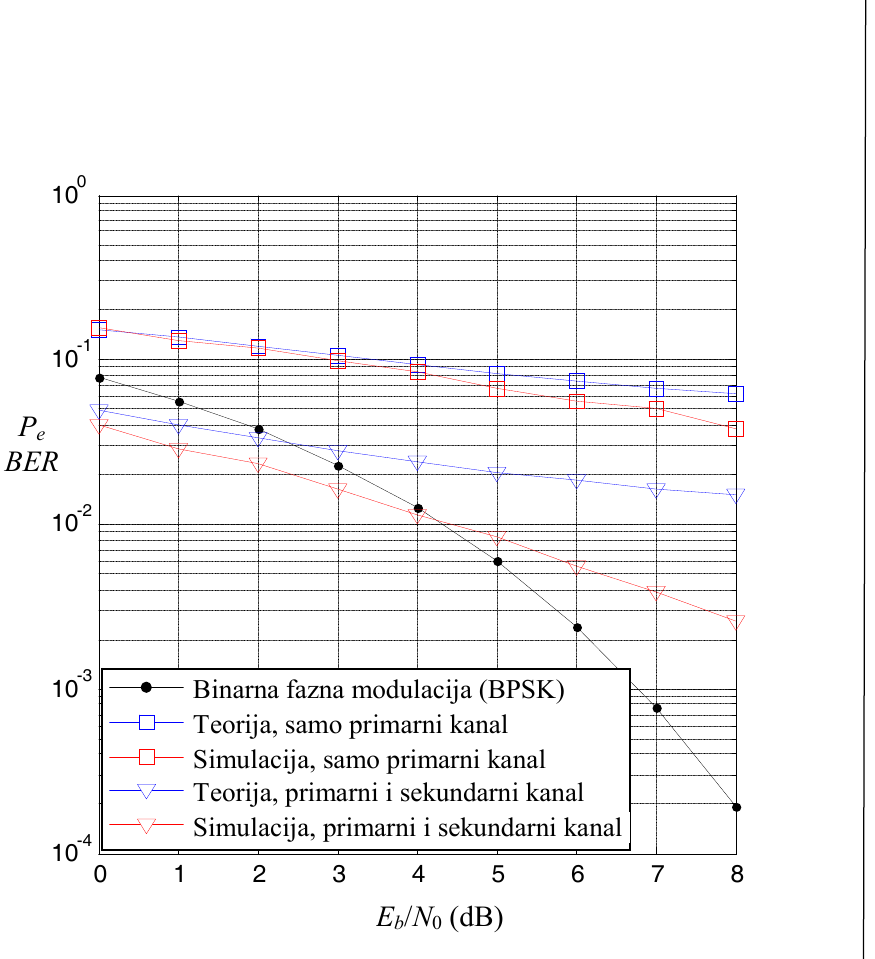
Figure 5 – Graphs of the probability of error as a function of the signal to noise ratio in the channel with both flat fading and frequency selective fading, for 4 users, the processing gain 2 β = 100 and the average delay τ =